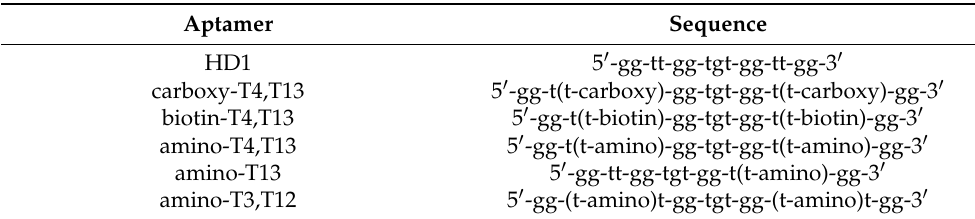
Table 2. The sequences of HD1 and its modifications. The structures of modified nucleotides are provided in Figure 3.